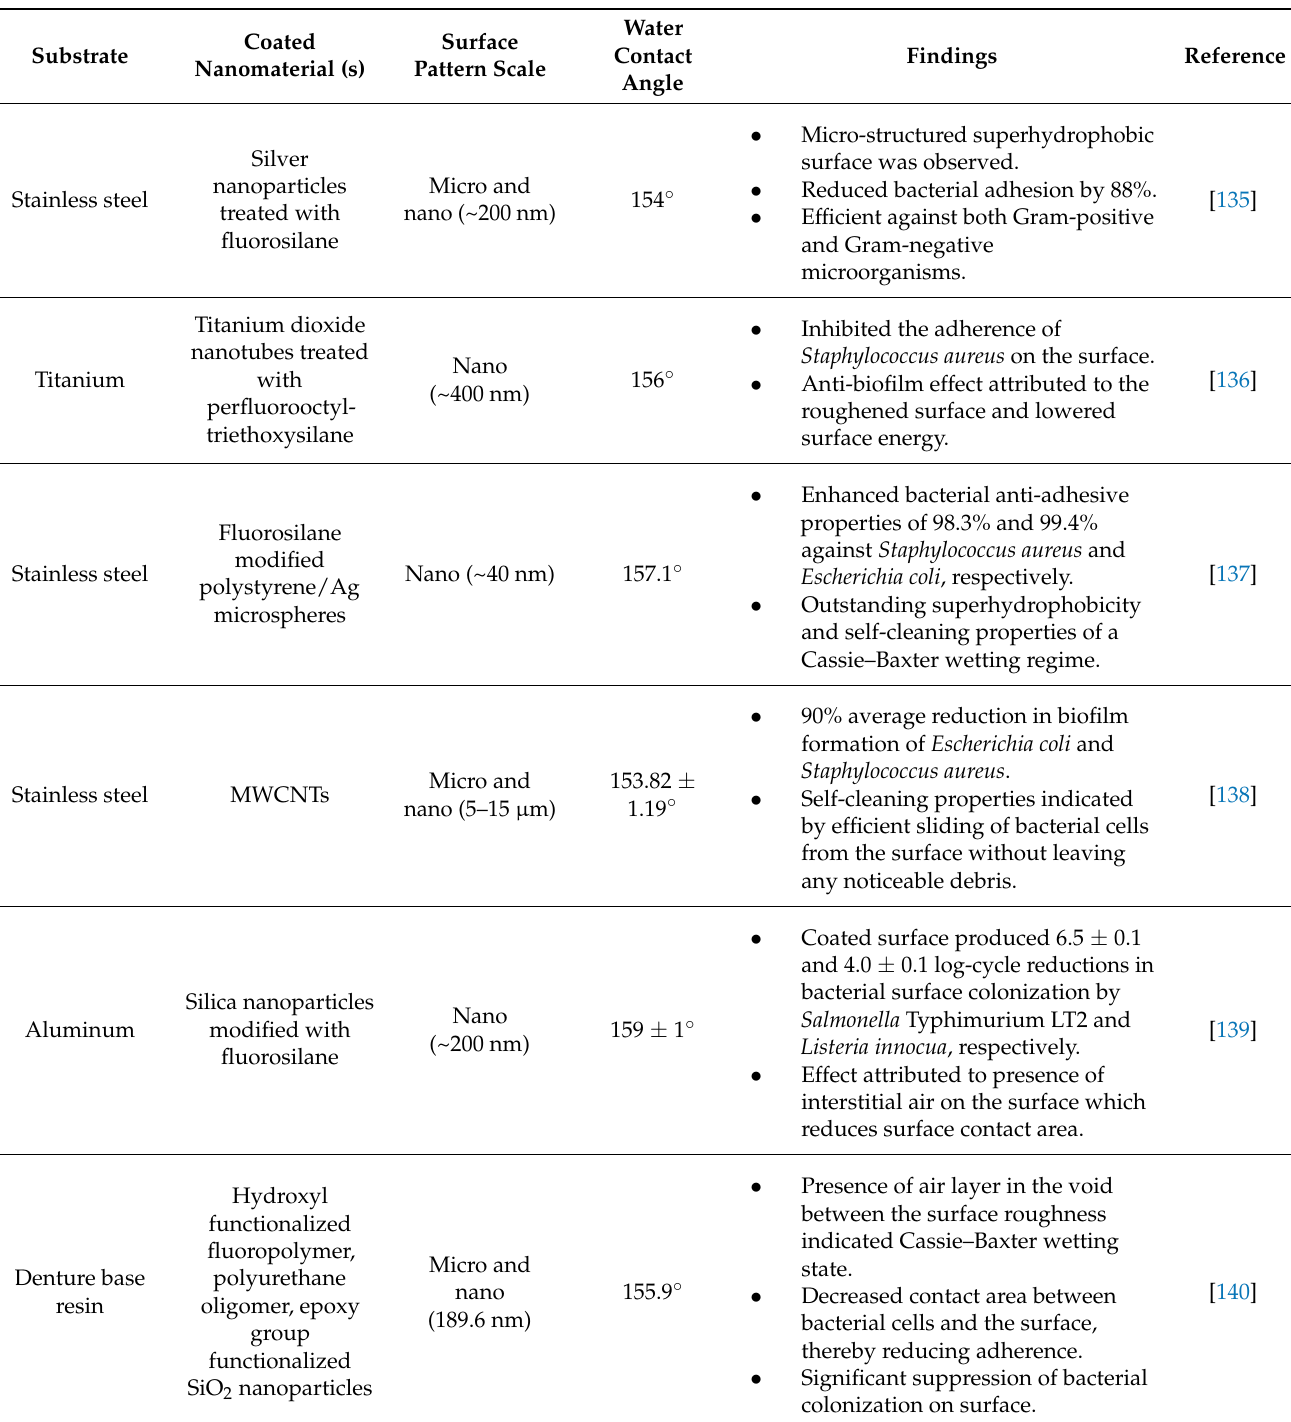
Table 4. Prior works that demonstrated notable anti-biofilm potential upon superhydrophobic nanocoating on substrate.